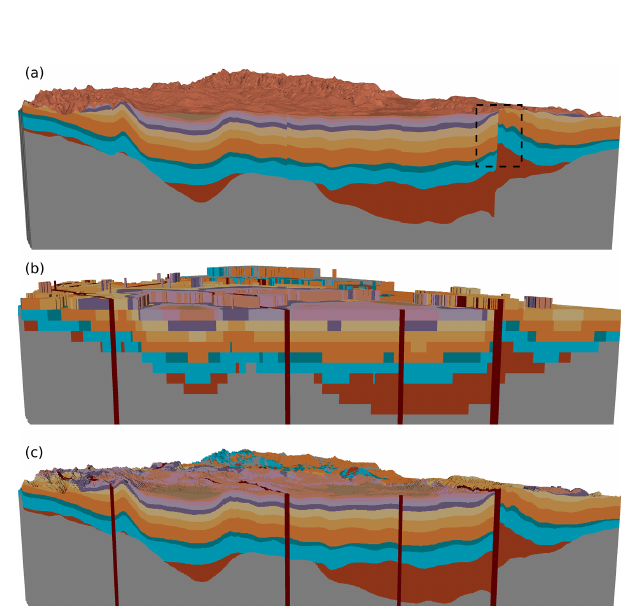
Figure 9. Cross section A–B for comparison of a coarse and a fine reconstruction of geological units to the original GOCAD model, vertical exaggeration 20 ; legend given in Fig. 3, cross section in × Fig. 1: (a) original structure model, (b) after reconstruction using a coarse resolution (vertical resolution (cid:49)z 250m), and (c) after ≈ reconstruction using a fine resolution ( (cid:49)z 11m); the dotted frame ≈ in panel (a) shows the position of the viewpoint in Fig.